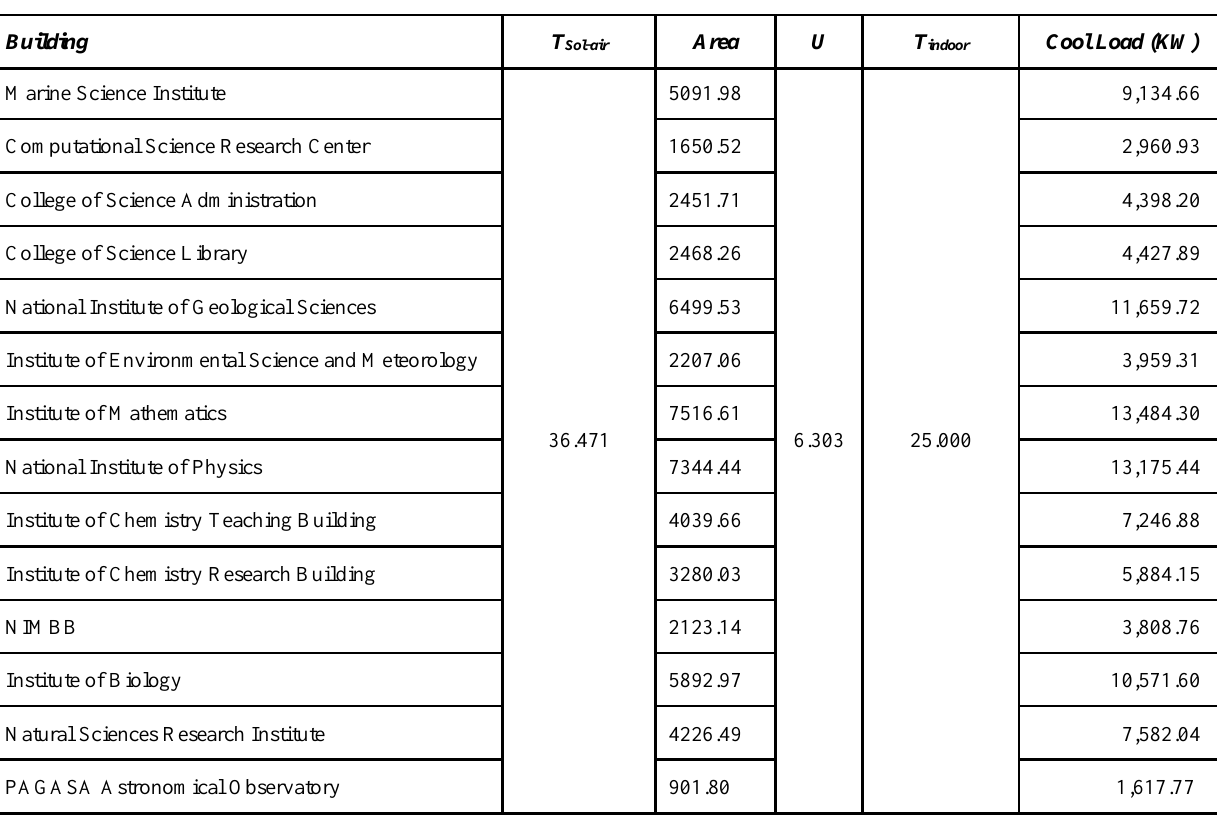
Table 3. Cooling Load Calculation (see section 2.2.2 for information on the